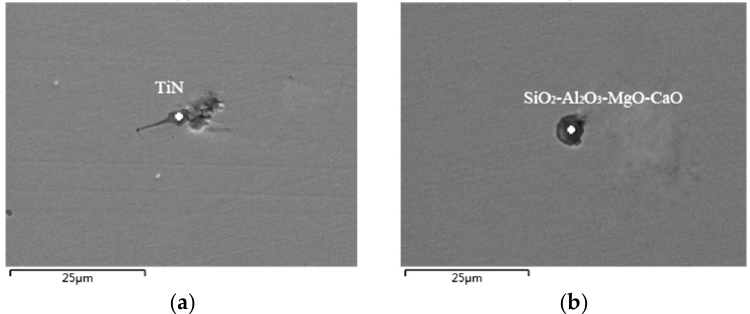
( c ) Figure 8. SEM and EDS analysis of inclusions in tundish. ( a ) Al 2 O 3 -TiO 2 ; ( b ) Al 2 O 3 -CaO; ( c ) Al 2 O 3 - SiO 2 -MnO-TiN. Through the SEM and EDS analysis of the inclusions in the tundish, it can be shown that the main types of the inclusions in steel samples are Al 2 O 3 -CaO, Al 2 O 3 -TiO 2 , Al 2 O 3 -SiO 2 -MnO-TiN composite inclusions, and the size difference of the inclusions is huge—the larger is about 50 μ m and the smaller is less than 10 μ m. It is not desirable for these composite inclusions which exist in steel to be seen in actual production. They mainly come from the cooling and solidification process of continuous casting, due to the decrease in solubility and element interactions. Oxygen, nitrogen, and other impure elements dissolved in molten steel were precipitated as the compound from the liquid phase or solid solution during the cooling and solidification process, and finally, they remained in the steel to form inclusions [11]. This kind of inclusion is harmful to the welding performance, corrosion resistance, and fatigue resistance of steel. However, by analyzing the solubility product of related compounds, we can find ways to reduce the generation of such inclusions.